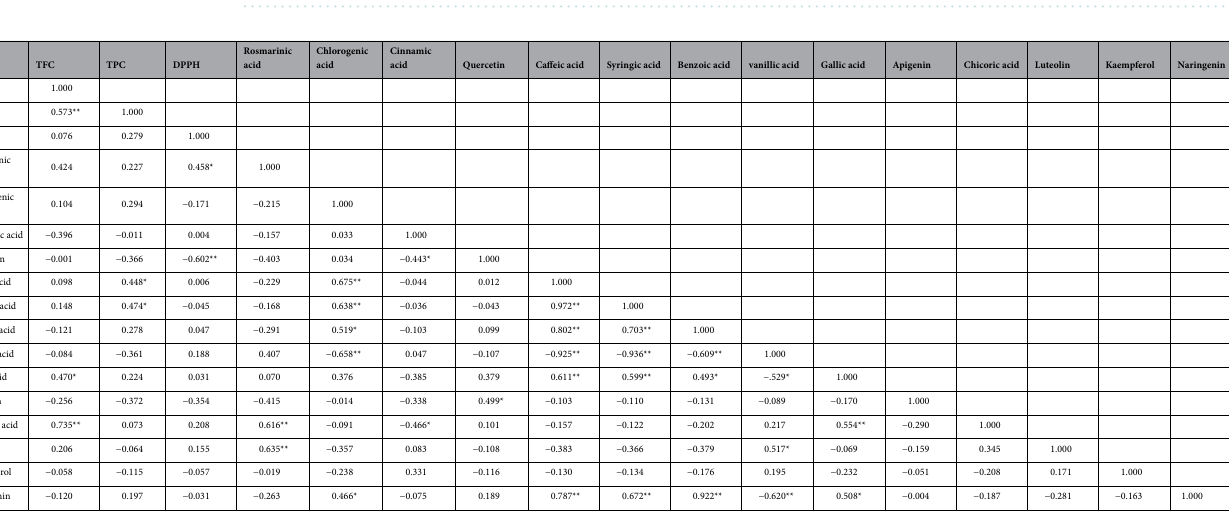
Figure 2. Agglomerative hierarchical clustering and principal component analysis (PCA) classification of oregano accessions based on their phenolic compounds and antioxidant properties. TPC: Total phenol content, TFC: Total flavonoids content.